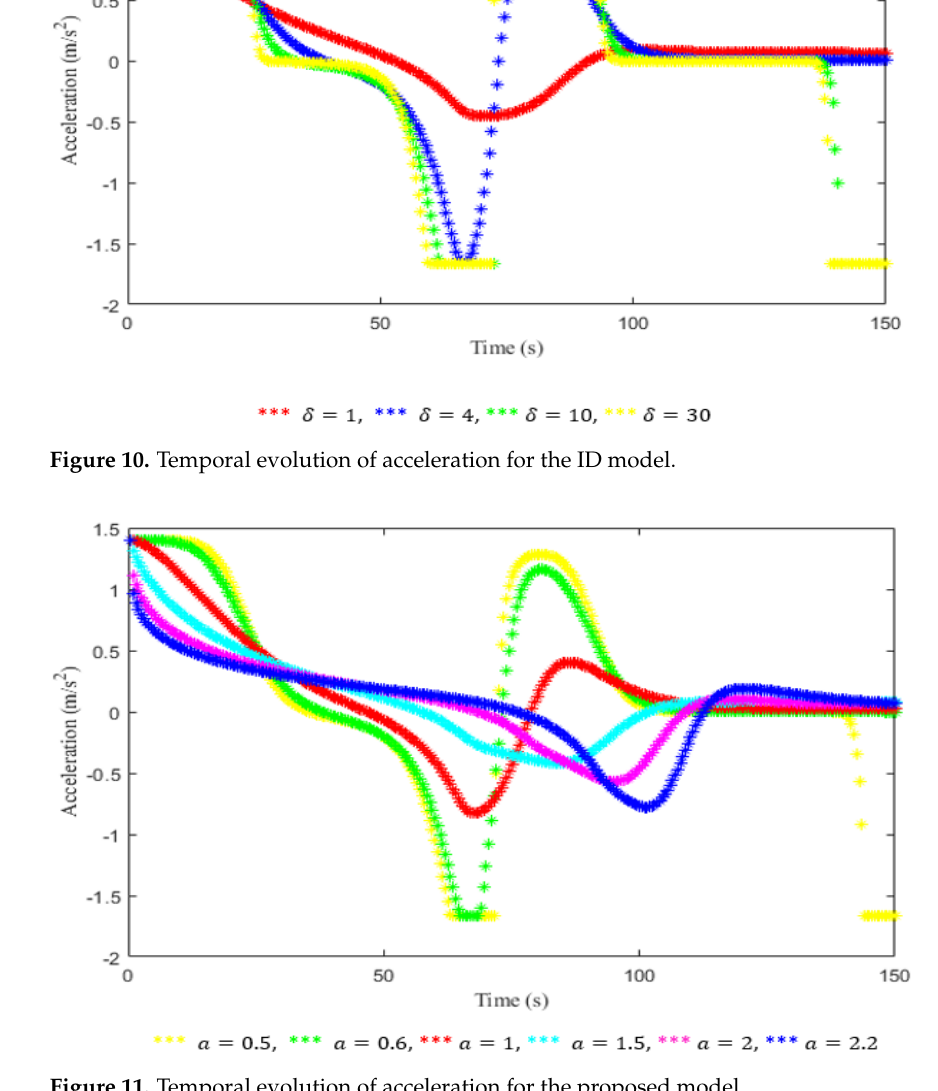
Figure 11. Temporal evolution of acceleration for the proposed model.